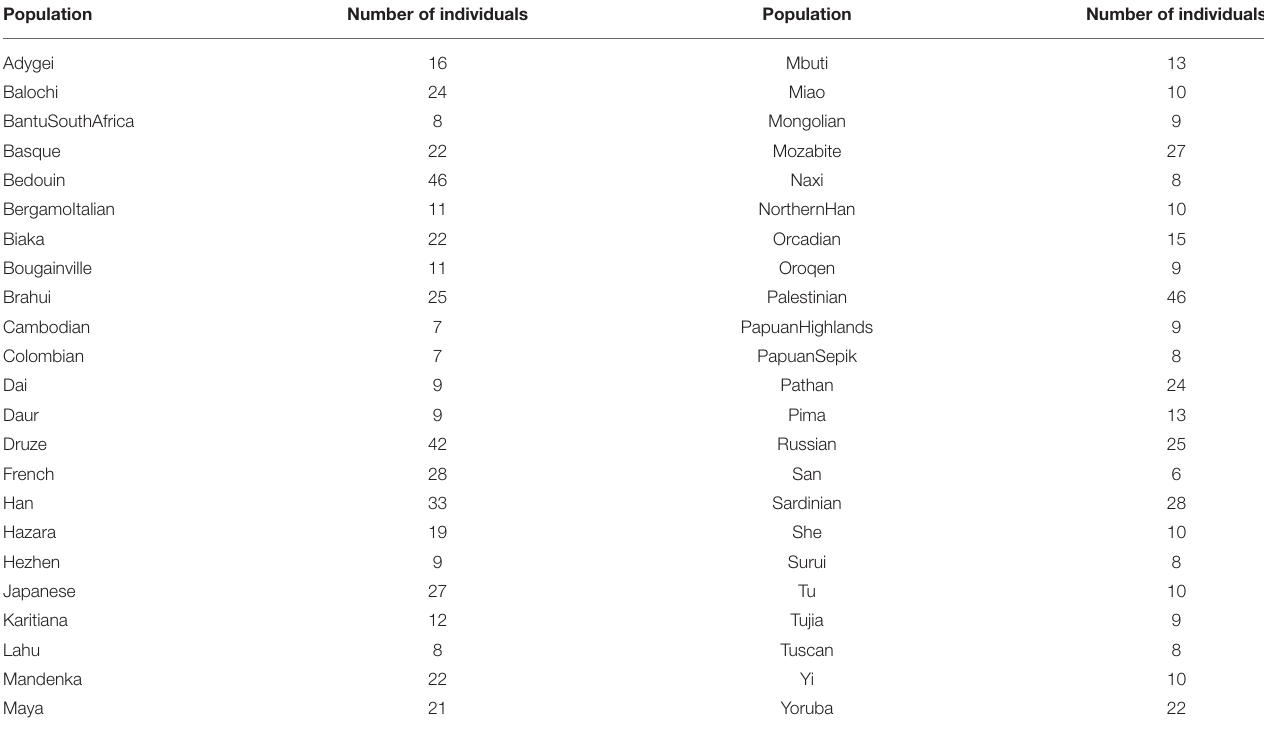
TABLE 1 | Overview of the 46 HGDP populations selected for the study.